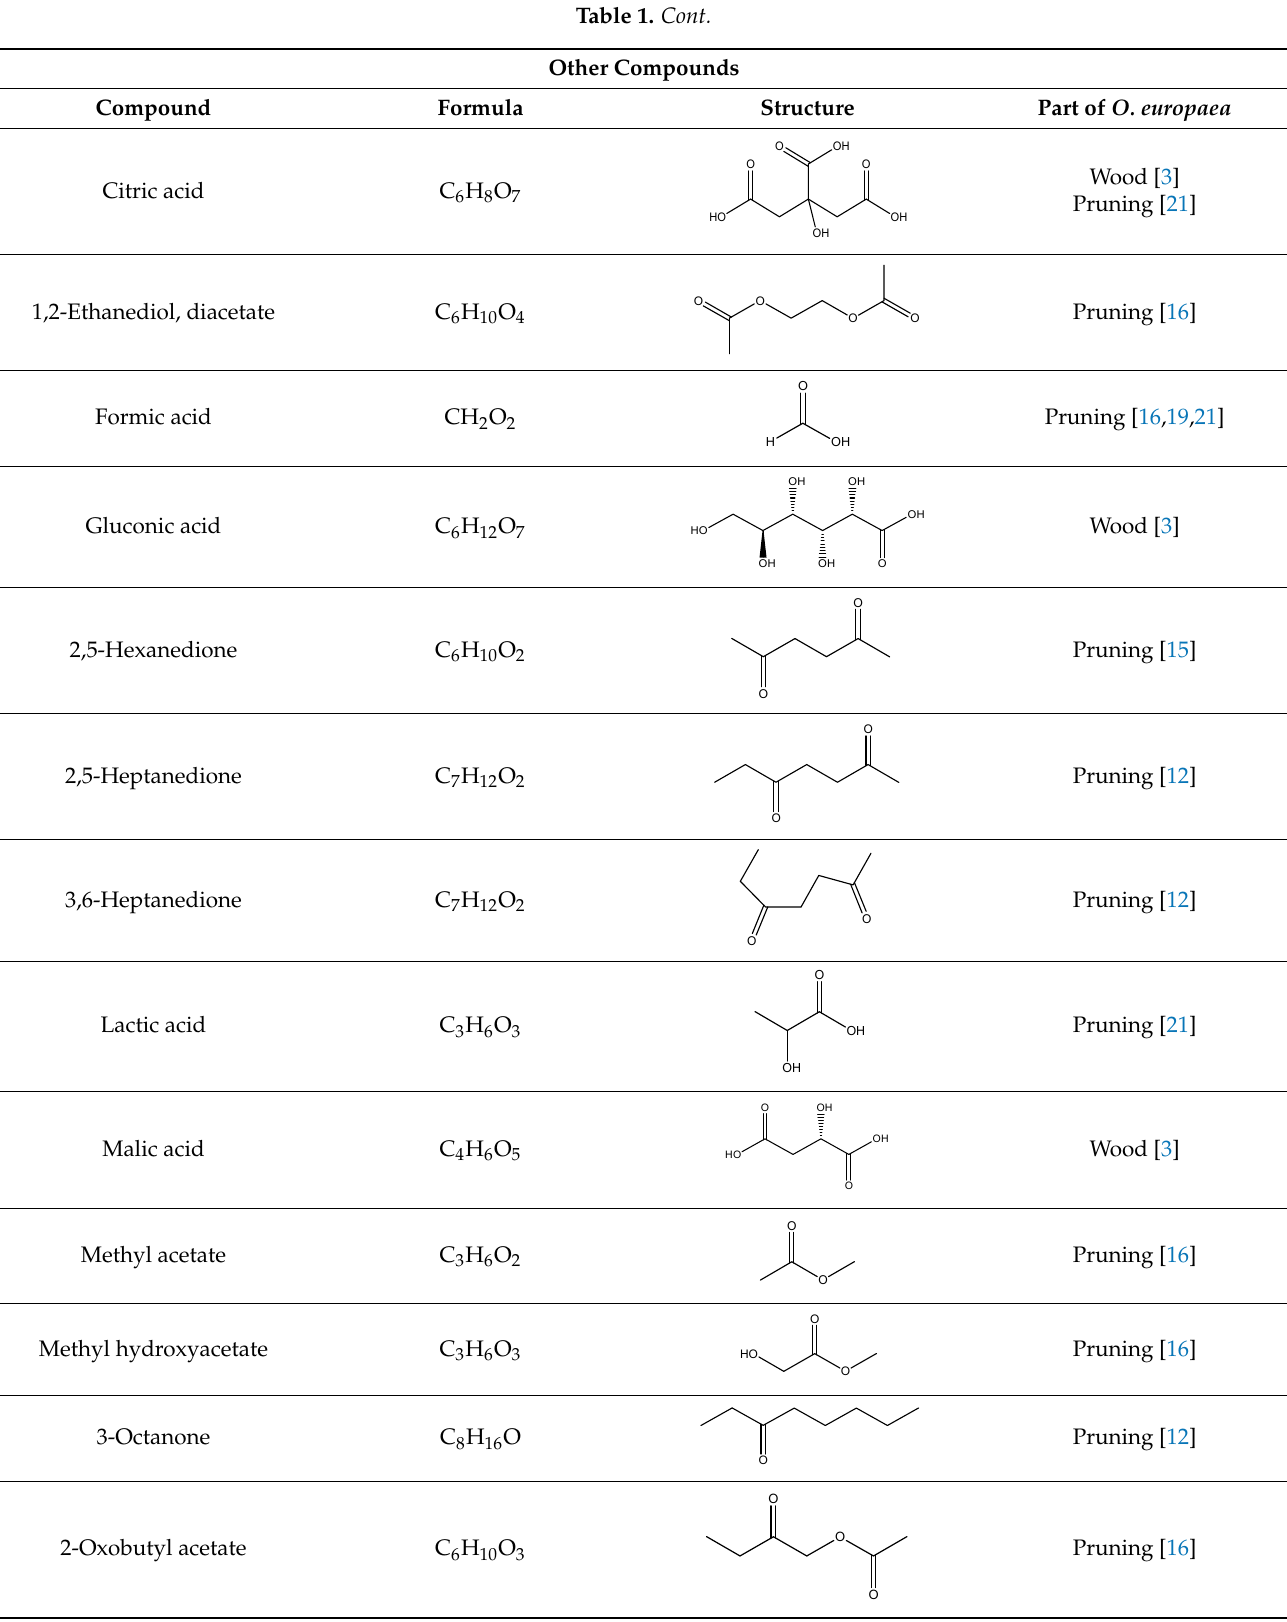
Table 1. Cont. Other Compounds Formula Structure Part of O.